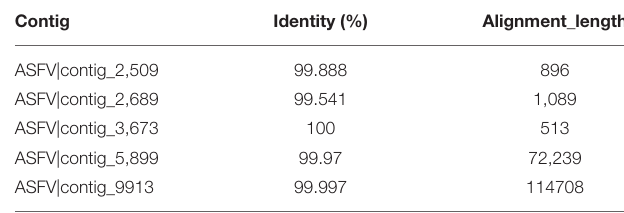
TABLE 9 | Gene prediction result statistics.